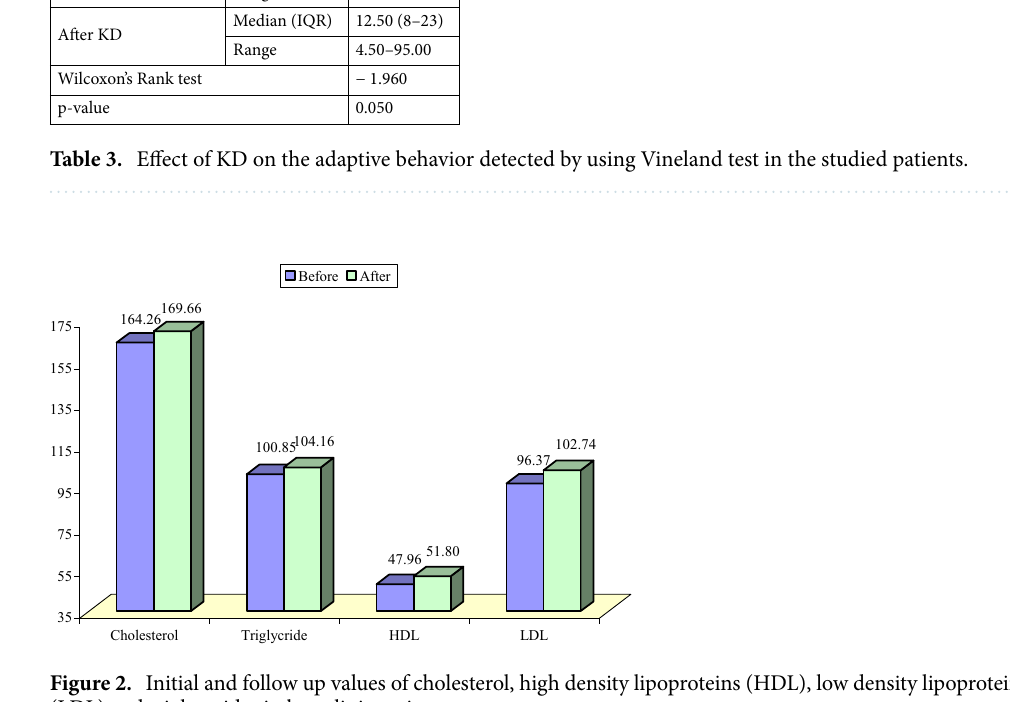
Figure 2. Initial and follow up values of cholesterol, high density lipoproteins (HDL), low density lipoproteins (LDL) and triglycerides in ketoclinic patients.